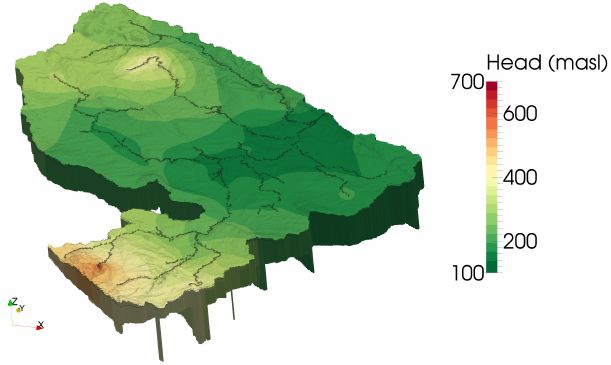
Figure 10. Hydraulic head distribution in the simulation model, ver- tical exaggeration 5 ; spiking elements at the bottom of the domain × visualize the position of the faults.